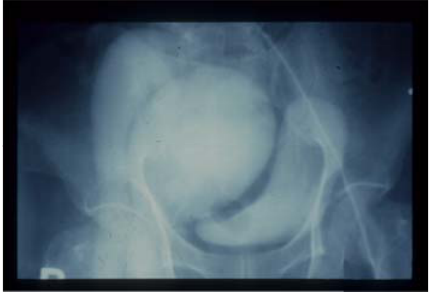
Figure2:Angiogrampresentedthelargeaneurysmofcommoniliac artery and